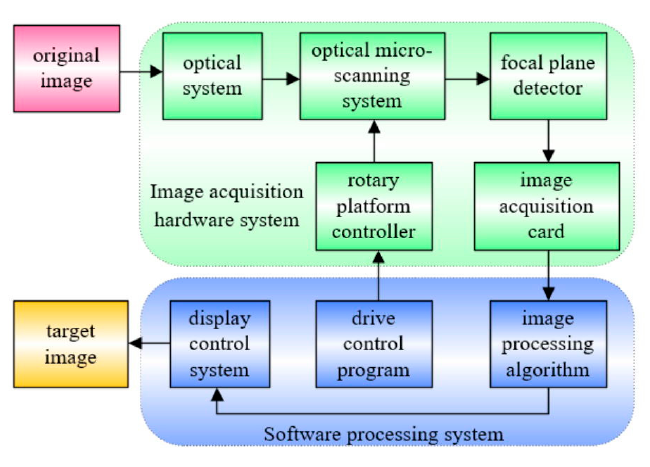
Figure 12. High-resolution thermal microscope imaging system block diagram.